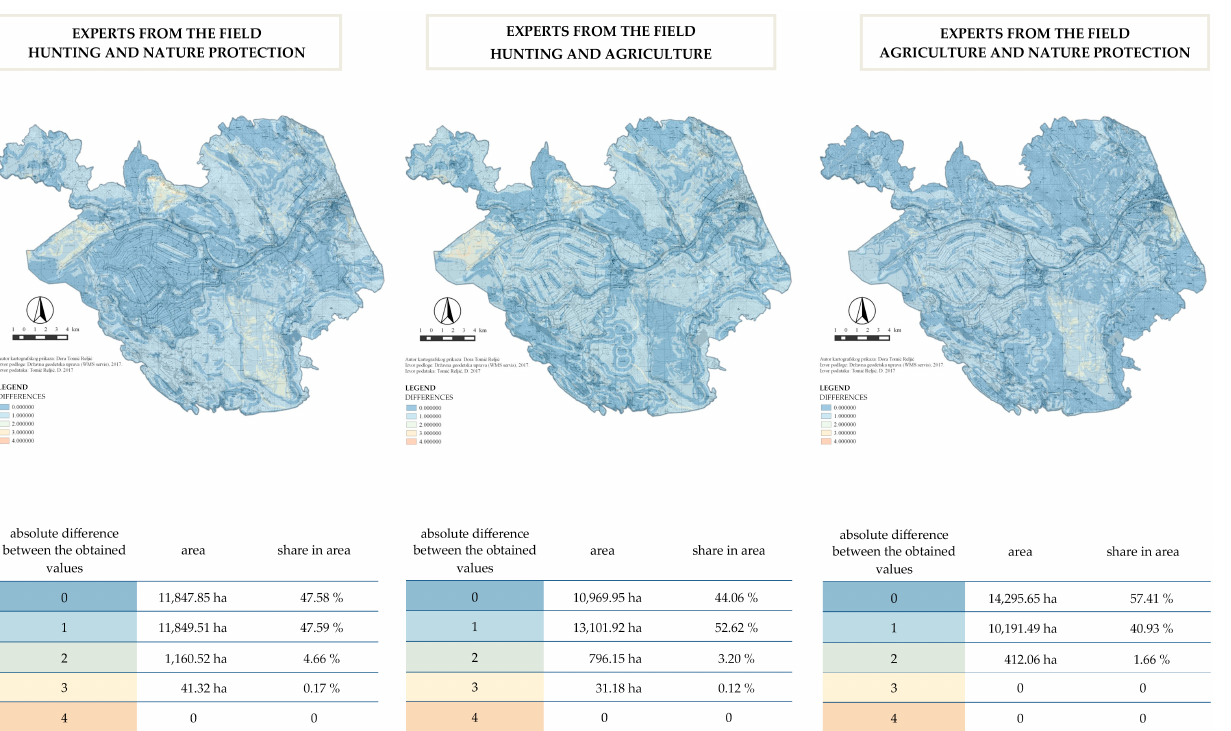
Figure 5 . The process of creating a combined model .